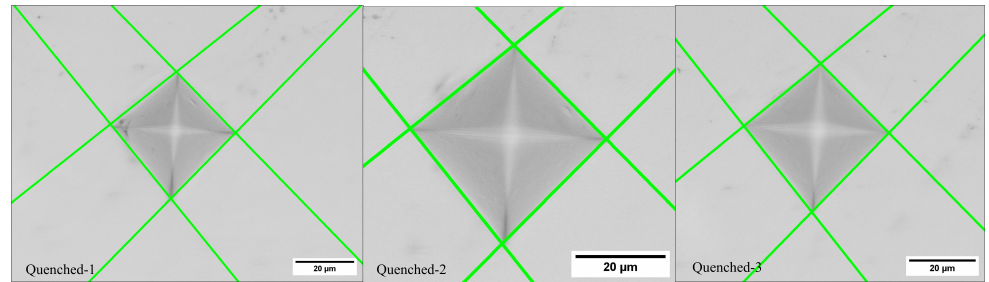
Figure A7. Corner detection on Steel samples at 10N applied force.